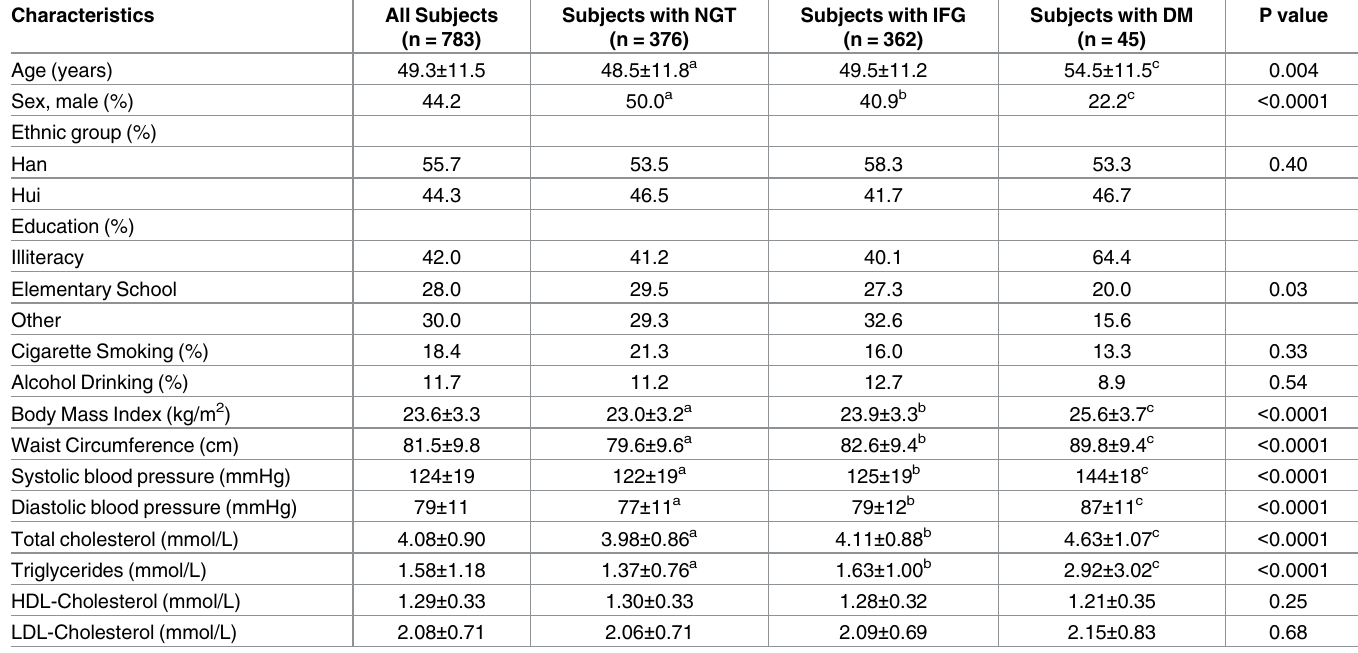
NGT, normal glucose tolerance; IFG, impaired fasting glucose; DM, diabetes mellitus; HDL, high-density lipoprotein; and LDL, low-density lipoprotein Values shown are mean ± standard deviation for continuous variables a, b and c indicates p < 0.05 for group comparisons: a for NGT vs. DM, b for NGT vs. IFG and c for IFG vs. DM.